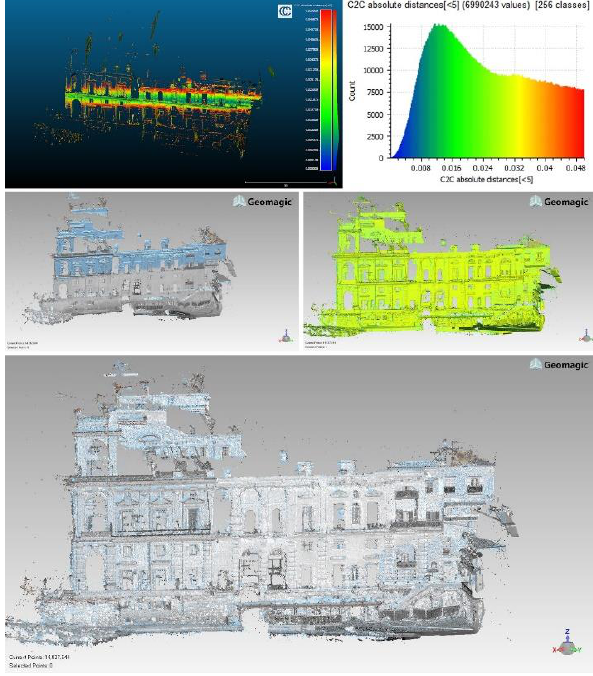
Figure 4. Alignment and deviation computing between the TLS clouds, in CloudCompare (above) and Geomagic